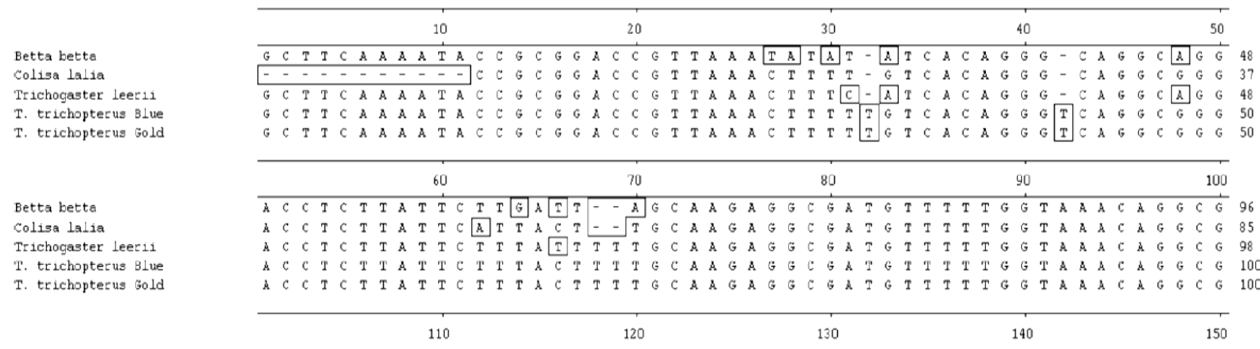
Figure 6. Comparison of the 12S rRNA gene nucleotide sequences (150bp) in Trichogaster trichopterus (blue gourami and gold gourami), T. leerii (pearl gourami), C. lalia (dwarf gourami), and B. betta (fighting fish) [2]. Biology 2021 , 10 , x FOR PEER REVIEW